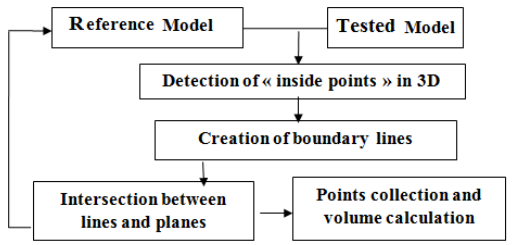
Figure 4: Flowchart of the method of intersection volume calcu-